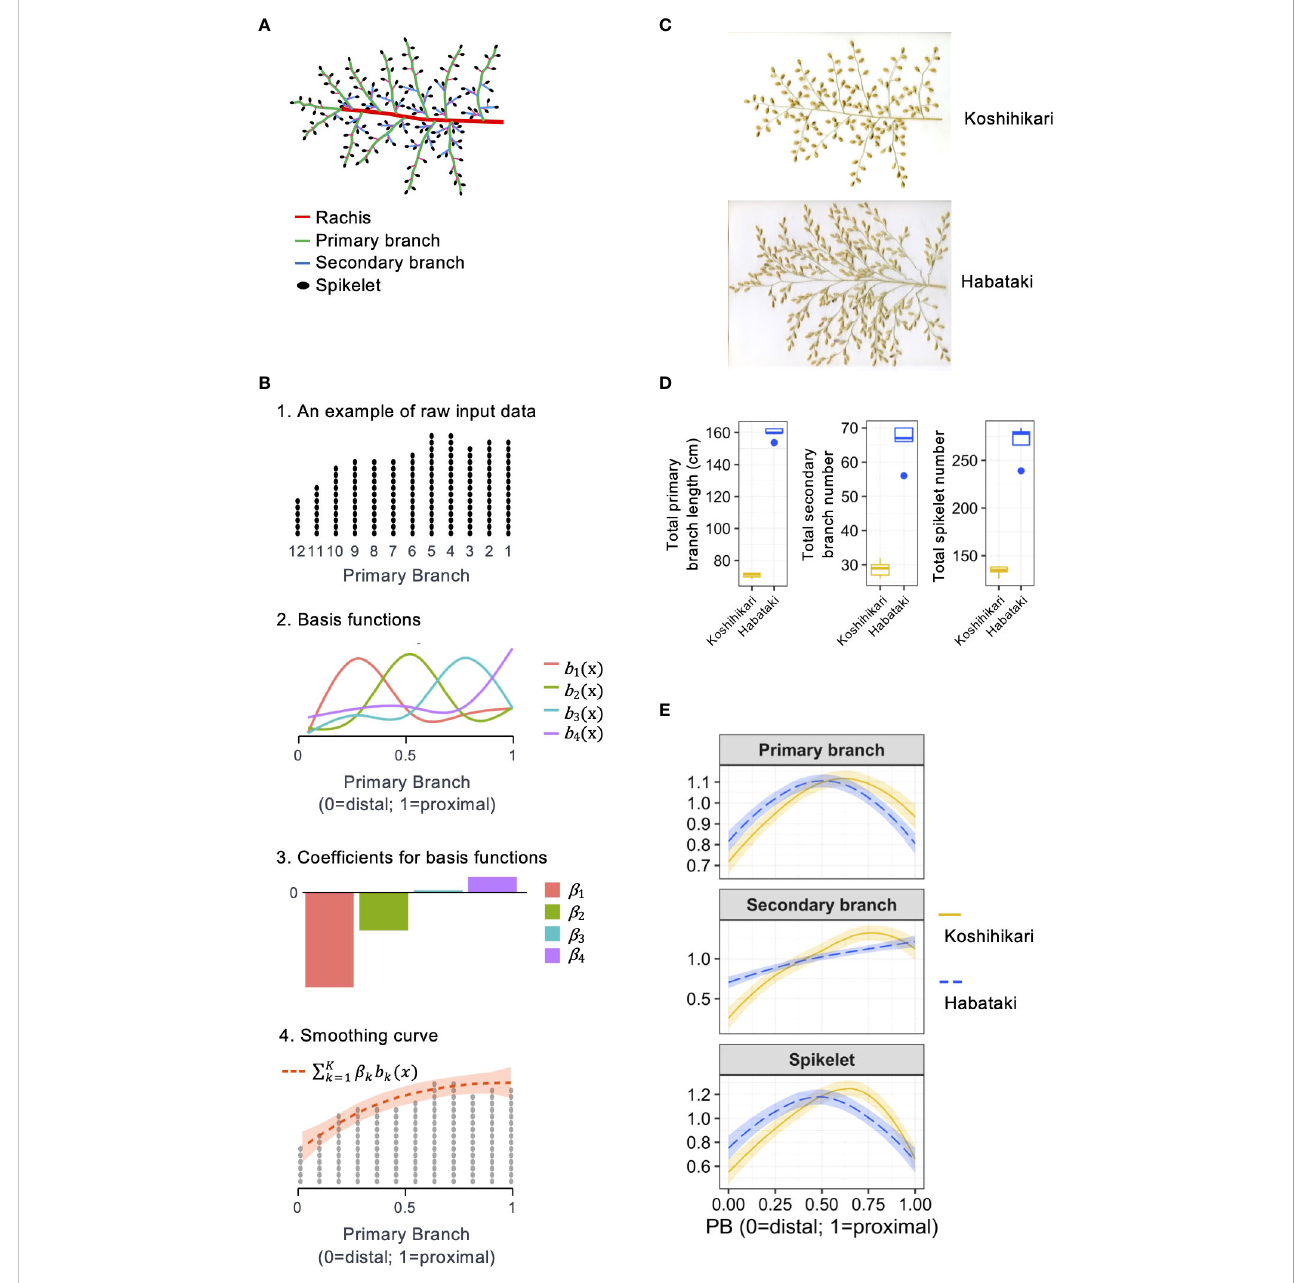
FIGURE 1 Method for the quantitative description of organ distribution patterns in rice panicle. (A) Schematic representation of the rice panicle architecture. (B) Schematic representation of the method used to describe the organ distribution pattern using a cubic smoothing spline. (C) Panicle morphologies of Koshihikari and Habataki. (D) Boxplots for phenotypic values of Koshihikari and Habataki. Box edges represent 0.25 and 0.75 quantiles with median values indicated by bold lines. Whiskers extend to data no more than 1.5 times the interquartile range, and remaining data are indicated by dots. (E) Smoothing curves of organ distribution patterns drawn for Koshihikari (yellow solid lines) and Habataki (blue dashed lines). The shaded areas represent the 95% con fi dence